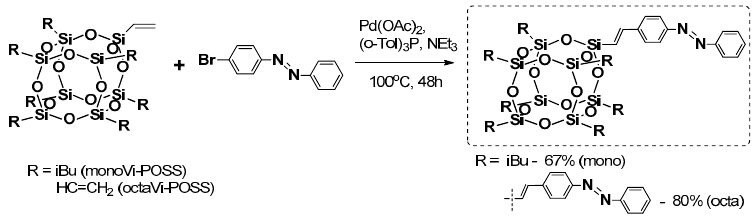
Figure 6. Mono- and octa-azobenzene-functionalized T 8 derivatives obtained in a Heck coupling reaction.